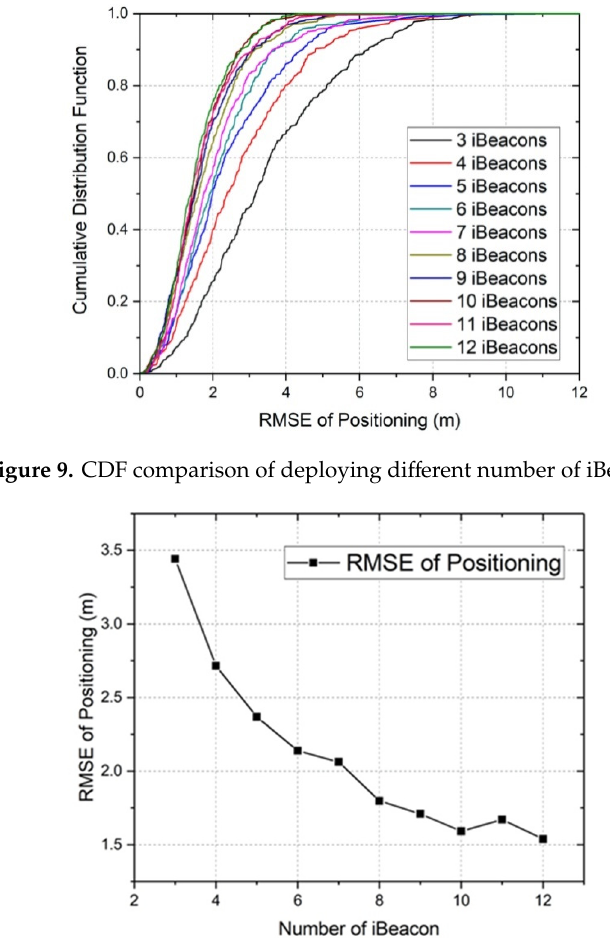
Figure 10 . Root-mean-square error (RMSE) of deploying different number of iBeacons.